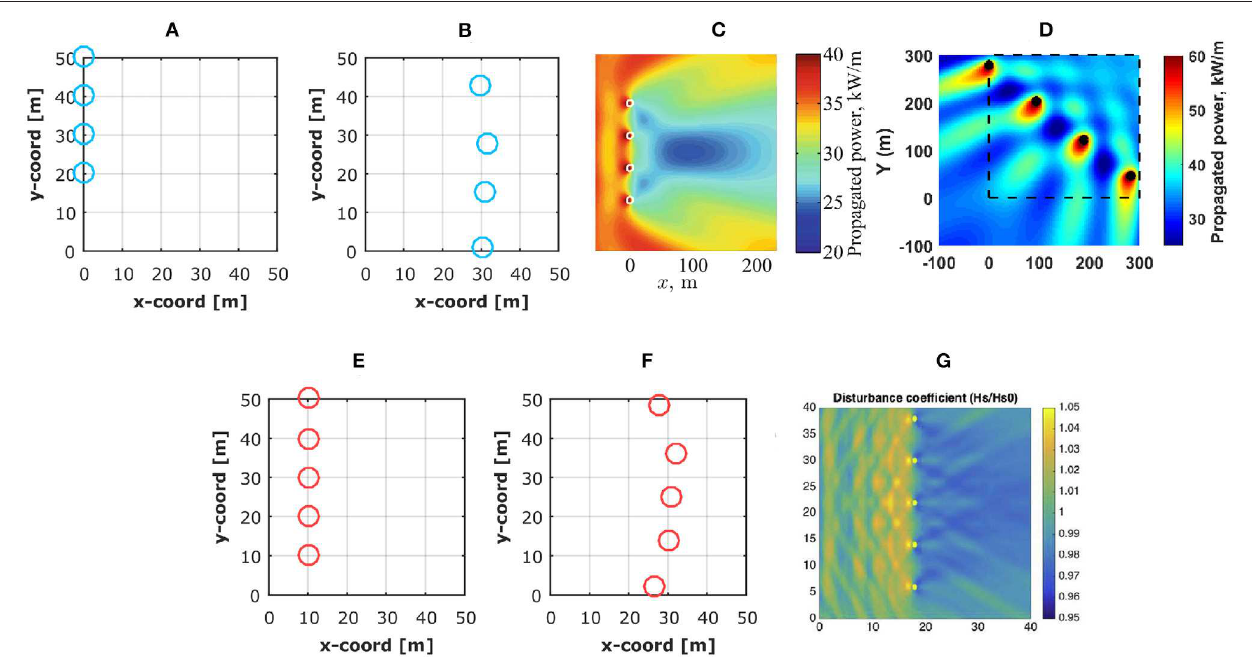
FIGURE 11 | Wave energy park optimization with metaheuristic optimization methods has produced similar results for small arrays at sites where the waves propagate within a narrow interval of predominant wave directions. The waves are propagating from left to right in all figure parts except (D) , where the waves propagate along a narrow interval around 240 ◦ . If the area of the park allows, the WECs tend to align perpendicular to the wave direction. The top row contains results for arrays with four WECs and the bottom row for five WECs. (A,B,E,F) GA optimization in long-crested waves with a gridded (A,E) and continuous (B,F) layout (Giassi and Göteman, 2018). (C) Multi-objective optimization using an evolutionary algorithm (Arbonès et al., 2018). (D) Optimal layout of four WECs obtained with a symmetric local search combined with a Nelder-Mead algorithm (Neshat et al., 2019b). (G) Optimal layout obtained with a GA in Sharp and DuPont (2018) for the case of a 4-m minimum separation